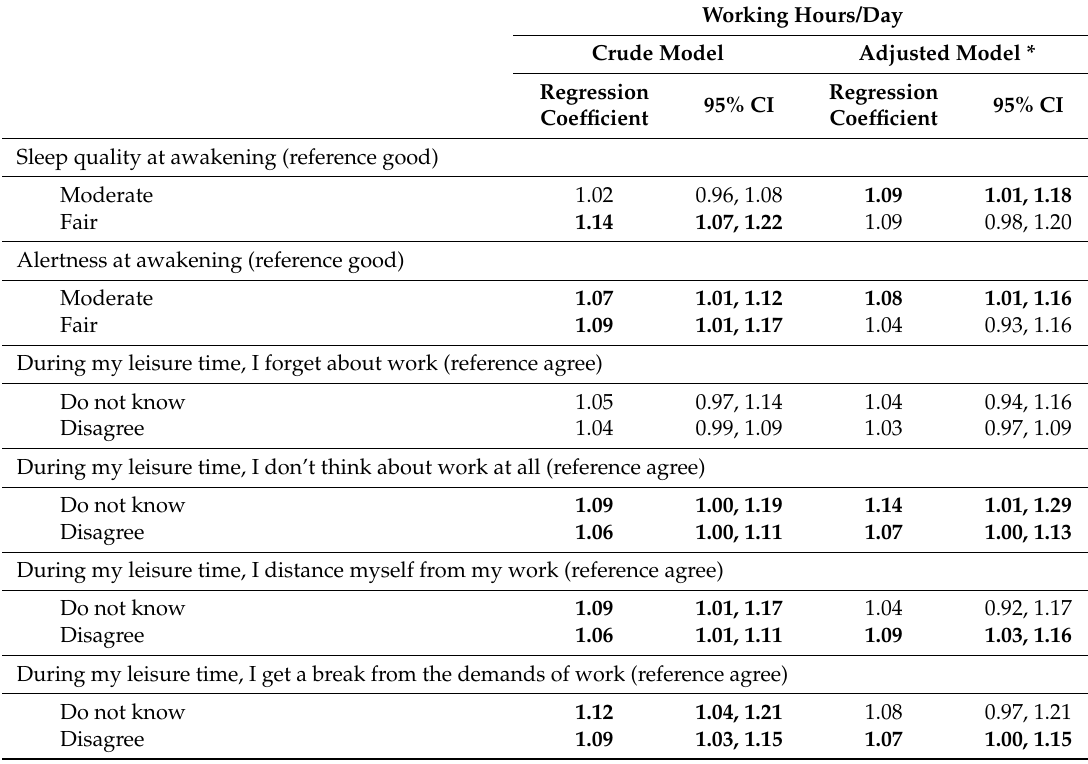
Table 4. Regression coefficients with 95% confidence intervals (CI) for associations between day-to-day ratings of sleep quality and alertness, recovery and detachment, and working hours in expert work.